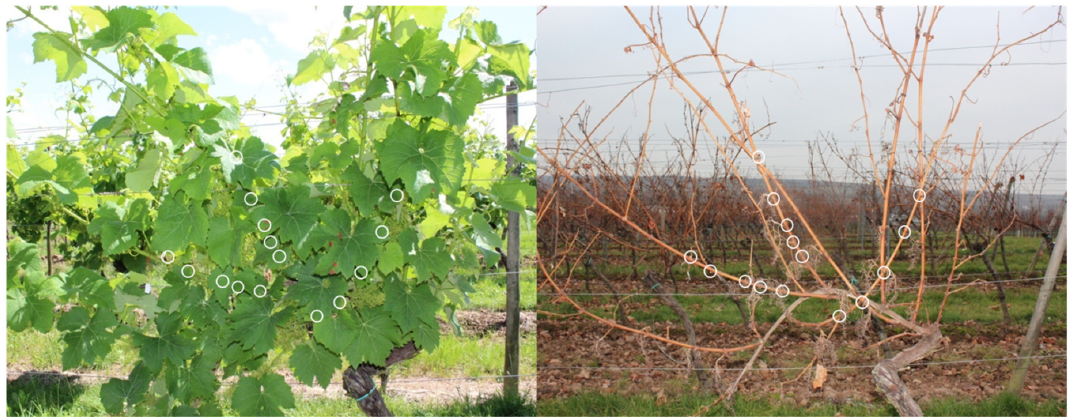
Figure 4. A representative vine of “Calardis Musqué” on 1 July and 16 December 2016. The fourth to eight nodes of the middle shoots are highlighted (white circles) to illustrate the positions of buds that were harvested. Buds were harvested throughout the season from several different vines of this variety.